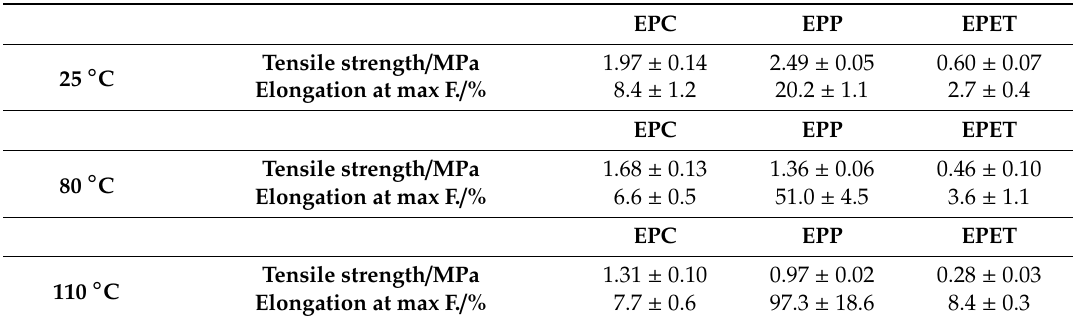
Table 3. Comparison of elongation at max. F and tensile strength of EPC, EPP, and EPET.